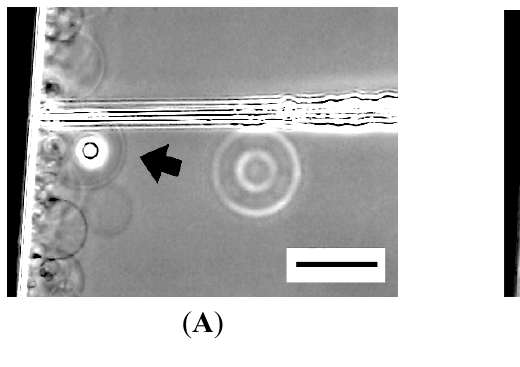
Figure 9. Formation of an OVV from a semi-spherical membrane by physical detachment from the electrode by a microneedle. Images are a semi-sphere before ( A , arrow) and after ( B ) detachment by using a microneedle. Bar = 50 μ